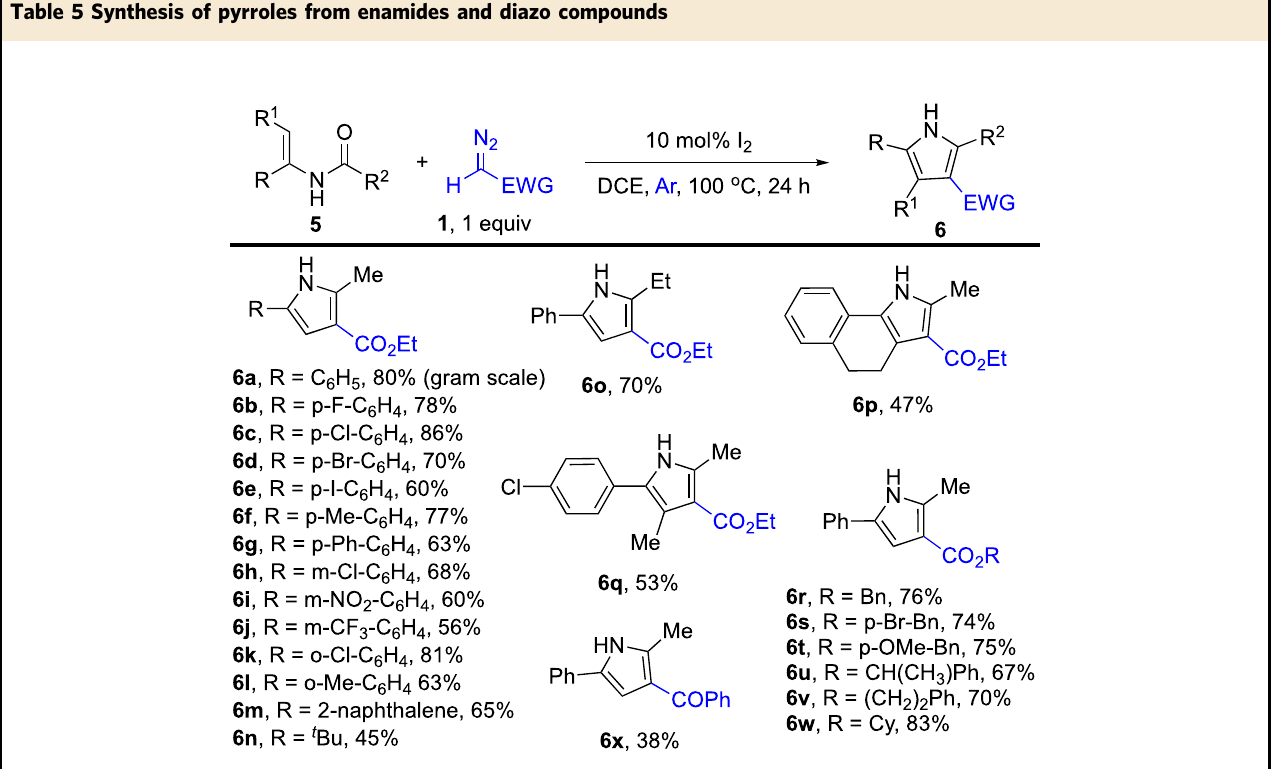
Table 5 Synthesis of pyrroles from enamides and diazo